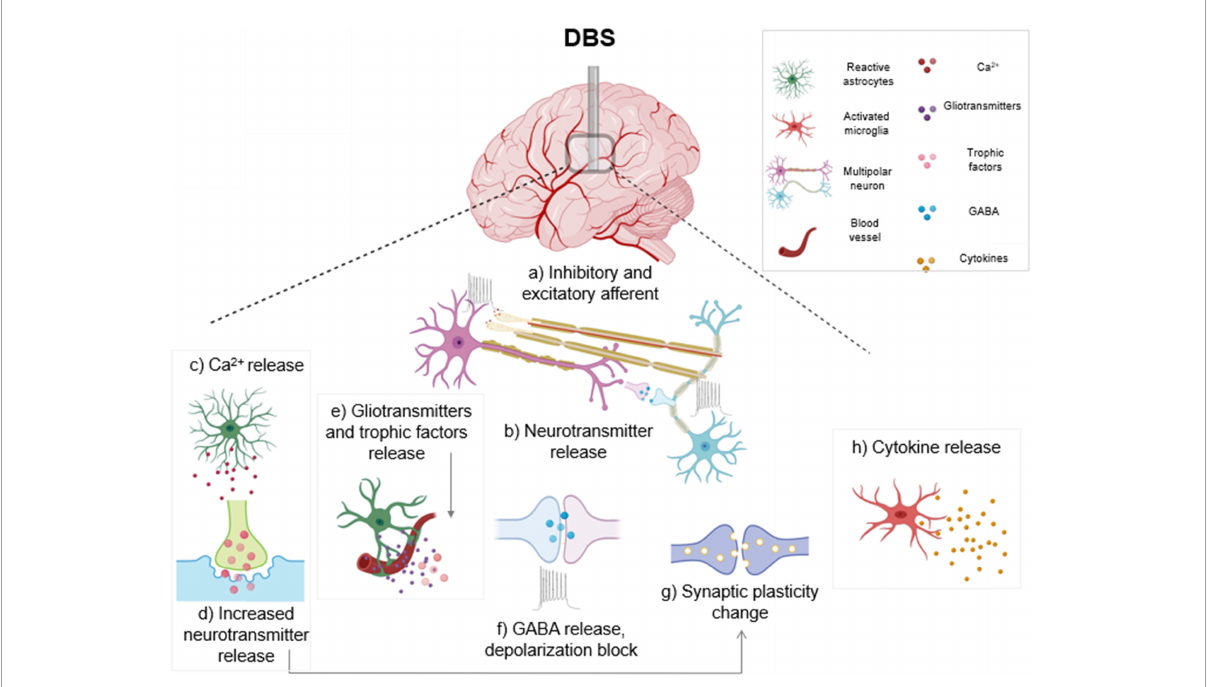
FIGURE1 Electrical and cellular effects of deep brain stimulation (DBS): High frequency DBS causes axonal action potentials and depolarization of inhibitory and excitatory fibers projecting to target neurons (a) and induces release of neurotransmitters (b). In response to stimulation, activated astrocytes release calcium (c), gliotransmitters and trophic factors (e). Increased calcium from activated astrocytes also triggers neurotransmitter and gliotransmitter release (d) which can modulate synaptic transmission. DBS causes subsequent release of the inhibitory transmitter γ -aminobutyric acid (GABA), and a depolarization block which causes reduced activity in neuronal cell bodies (f). Stimulation can also generate synaptic plasticity changes, which can lead to long term potentiation (g). DBS induces an activated ameboid morphology in microglia and an upregulation of cytokines is observed (h). Boxed panels indicate effects on non-neuronal cell types (Hamani and Temel, 2012; Jakobs et al., 2019; Lozano et al.,